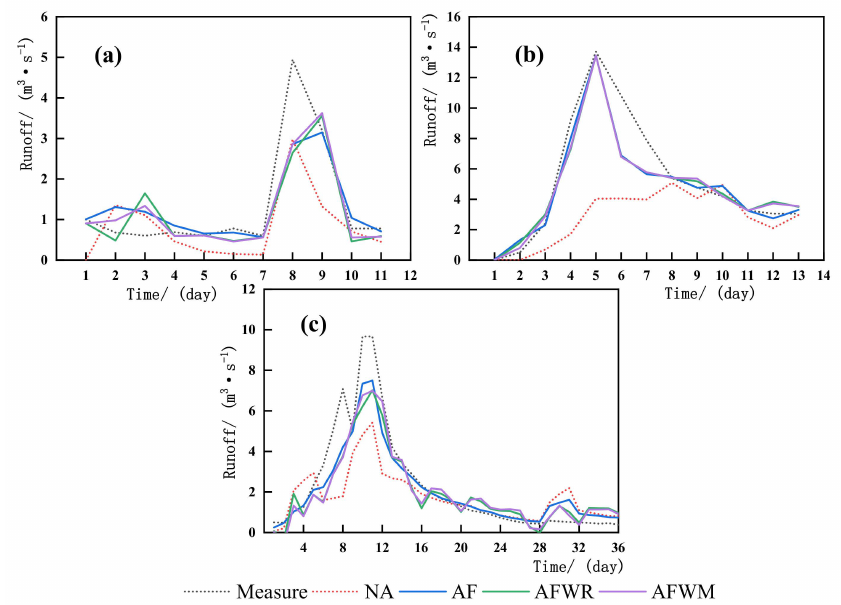
Figure 5. Variation in the flood runoff for small floods for the measurement and four assimilation settings for the three stations: ( a ) Dage; ( b ) Gubeikou; ( c )